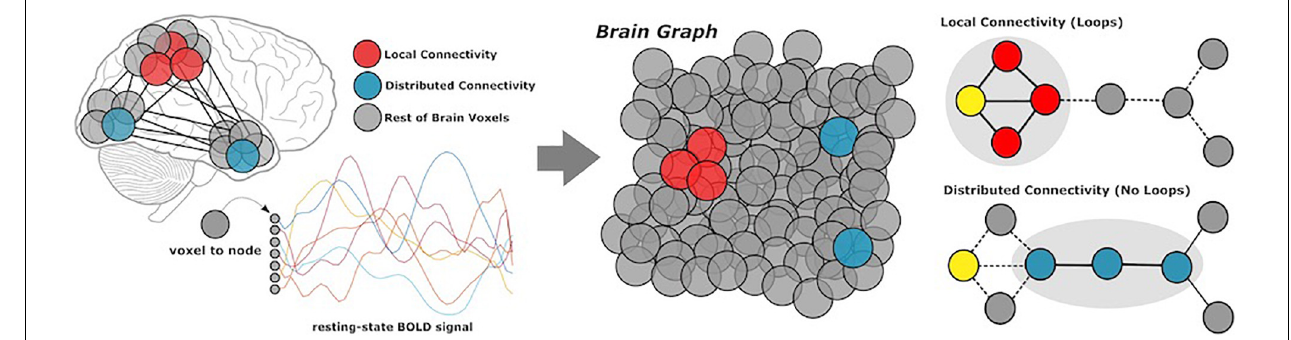
FIGURE 1 | Methods overview. Participants underwent resting-state functional MRI scans, from which we extracted BOLD data of all gray matter voxels in the cerebral cortex. Based on coactivation patterns between voxels, we performed local and distributed functional connectivity analysis to characterize network modularity. Local connectivity describes links within modules, whereas distributed connectivity captures the relatively smaller set of links which communicate between